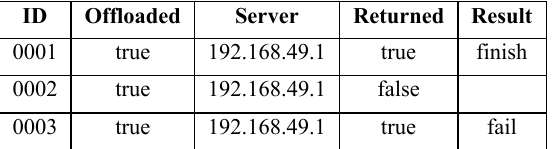
Table 1: Example of offloaded code